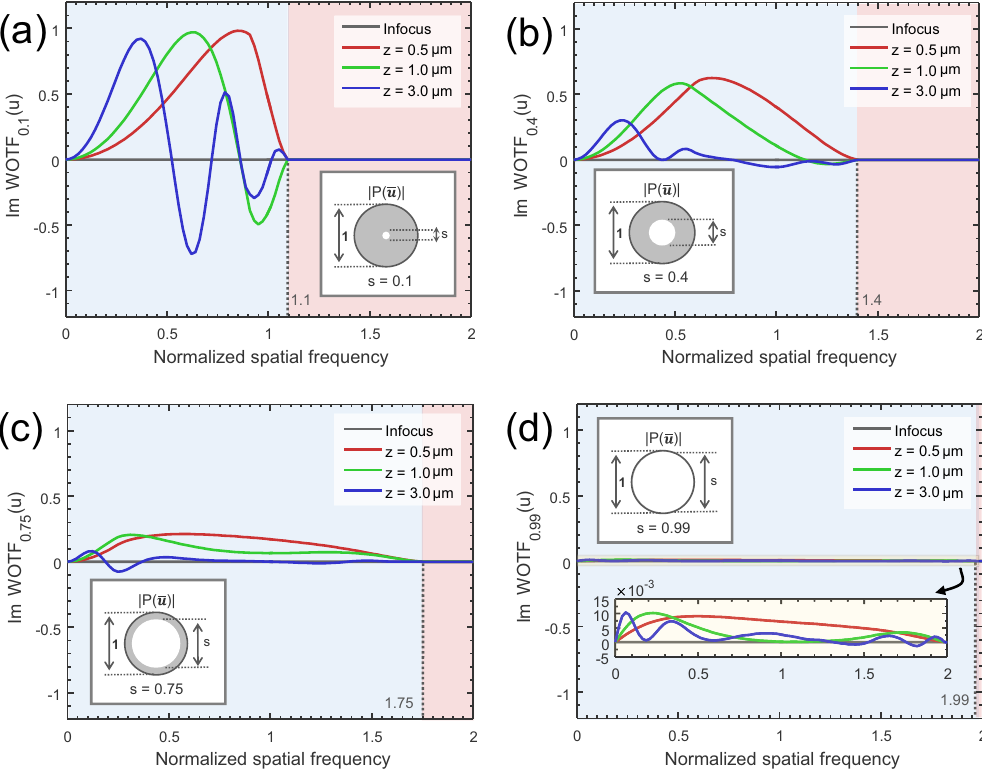
Figure 3. The imaginary part of WOTF (phase WOTF) for various coherent parameters and defocus distances ( NA obj = 0.8, λ = 550 nm, the spatial frequency coordinate is normalized against the coherent resolution limit NA obj / λ ). ( a ) s = 0.1; ( b ) s = 0.4; ( c ) s = 0.75; ( d ) s =